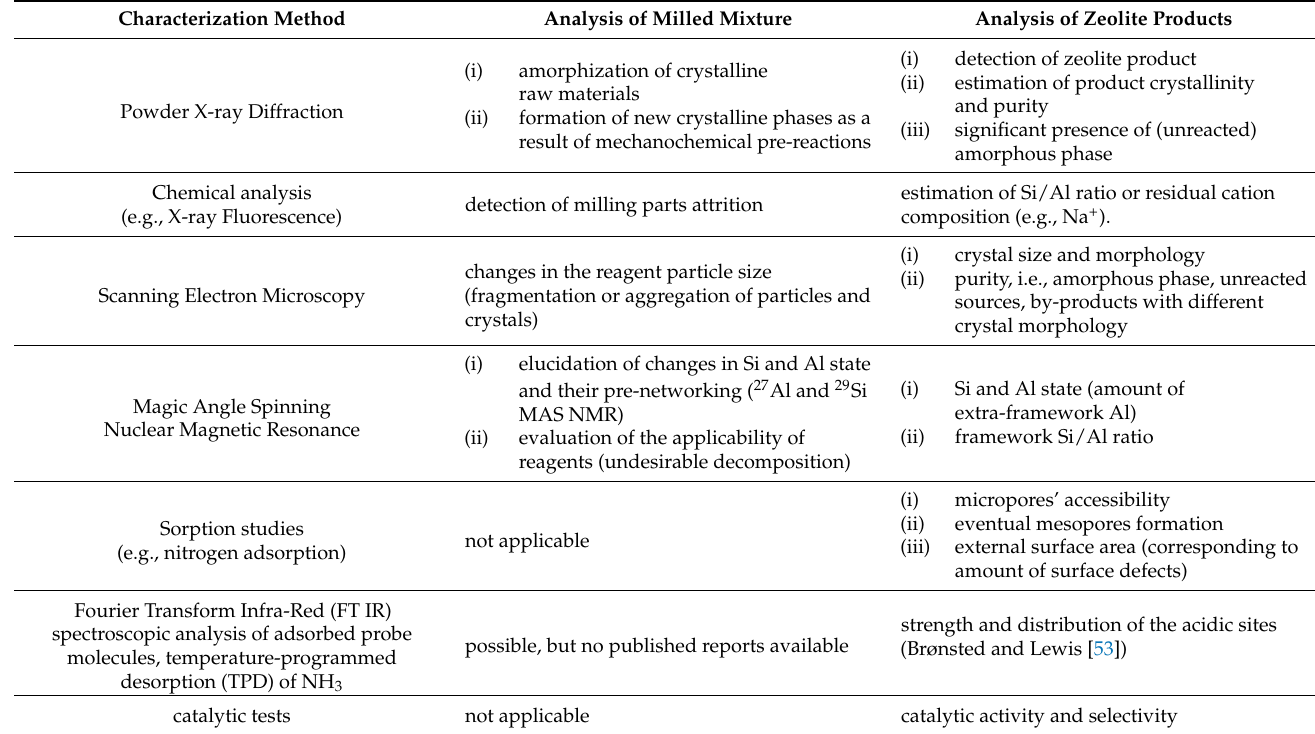
Table 6. Applicability of analytical methods for characterization of milled mixtures and obtained